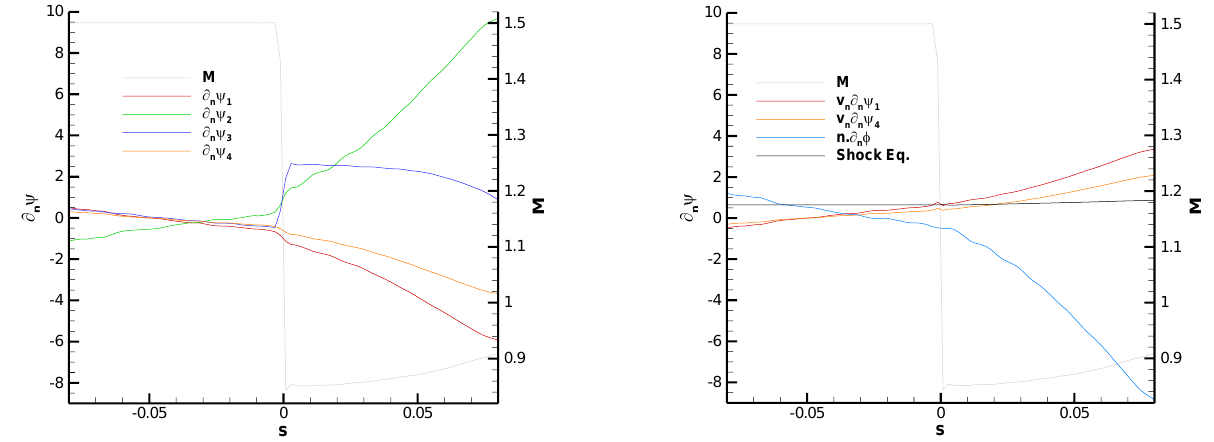
Figure 9. Flow past a NACA0012 airfoil at M = 1.5 and α = 0°. Adjoint normal derivatives and shock relations across the bow shock.